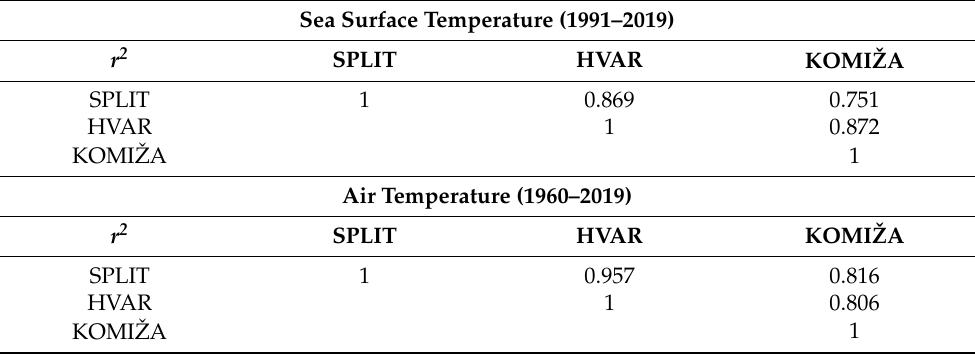
Table 5. Matrix table of the r –squared values of the linear correlation coefficients, r 2 , calculated from the time series of the mean annual SST and the mean annual air